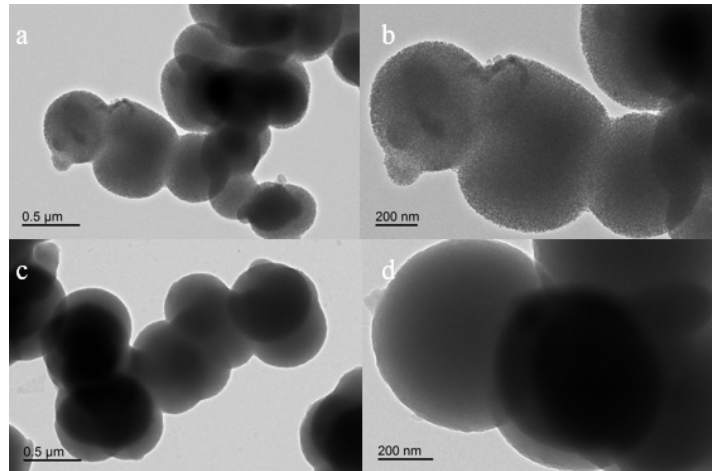
Figure 5. TEM images of phosphate imprinted SiO 2 (scale bar: ( a ) 500 nm, ( b ) 200 nm) and PNIPAM/SiO 2 hybrid particles (scale bar: ( c ) 500 nm, ( d ) 200 nm). PNIPAM/SiO 2 hybrid particles (scale bar: ( c ) 500 nm, ( d ) 200